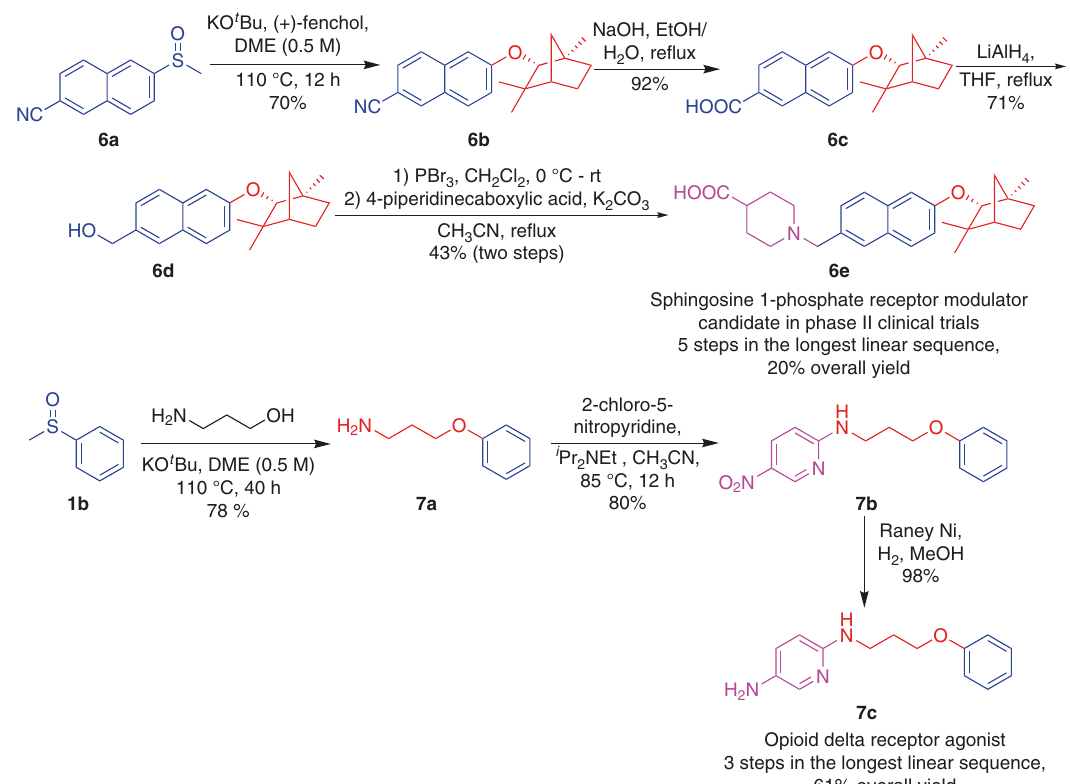
Sphingosine 1-phosphate receptor modulator candidate in phase II clinical trials 5 steps in the longest linear sequence, 20% overall yield